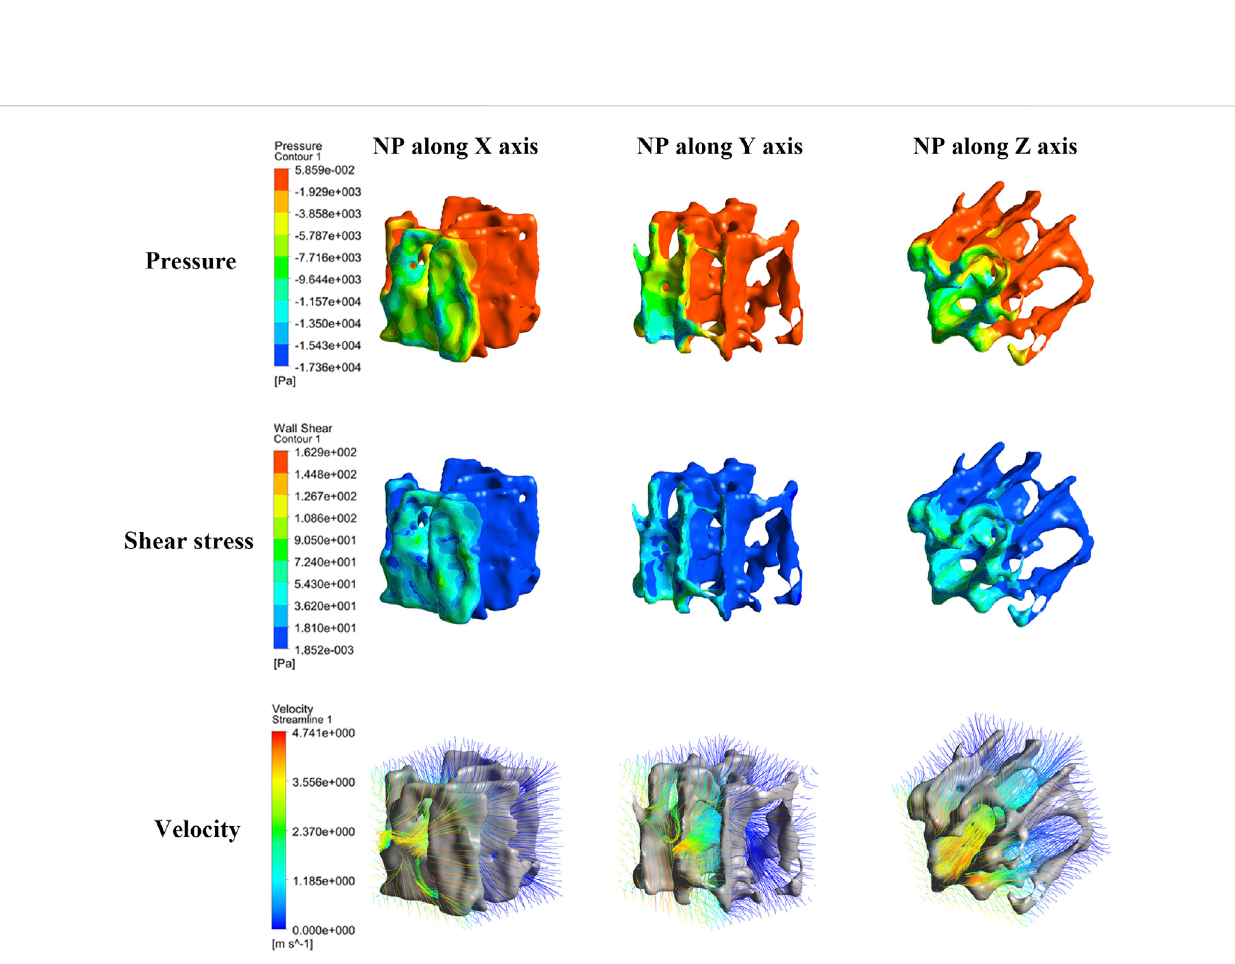
FIGURE 4 Nephogram ofdependencevariables induced byNPalongtheX-,Y-,andZ-axis (consider NP − 80 mmHgfor clarity). Thepressure, shearstressand morrow fl ow velocity concentrates near to the NP